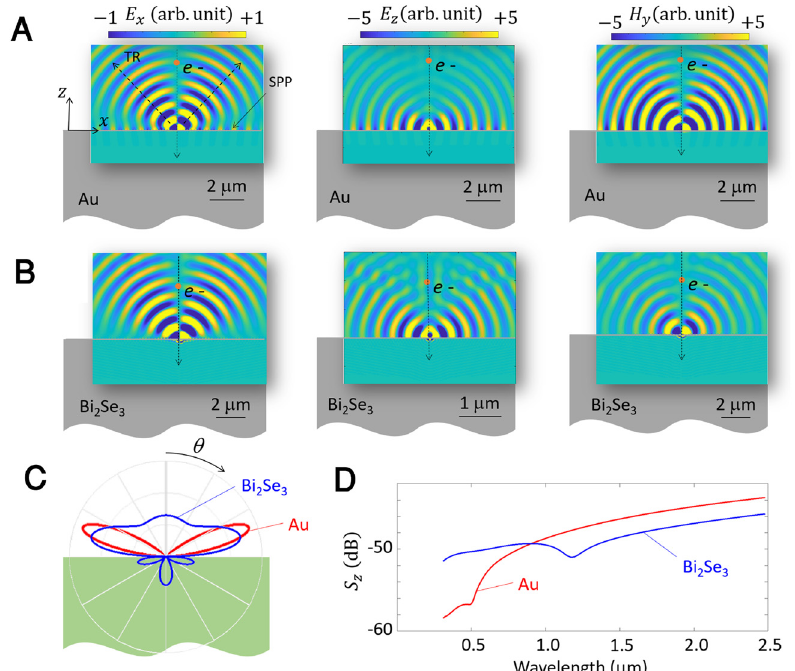
Figure 4: Calculated scattered amplitude for (A)vacuum/gold(B)vacuum/Bi 2 Se 3 interface for a moving electron transversing the surface of a material normal to the surface plane. (C) Radiation pattern of the emitted photons at an energy of E = 0.8 eV for gold and Bi 2 Se 3 surface. (D) Radiation power spectra ( z component of the poynting vector S z ) in the positive z direction for the TR from Au and Bi 2 Se 3 surfaces [54]. TR, transition